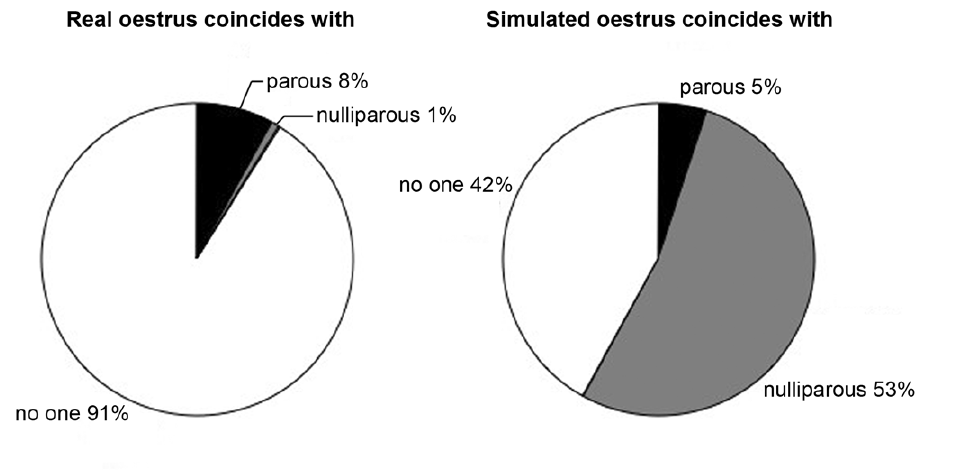
Figure 1. Coincident occurrence of real and false oestrus events. The first panel illustrates the pattern of occurrence of the 980 genuine oestrus events, and the second panel shows the 19 false oestrus events. Each panel shows how many events occurred singly in a family, how many coincided with a genuine oestrus event of another parous female, and how many with a nulliparous female.